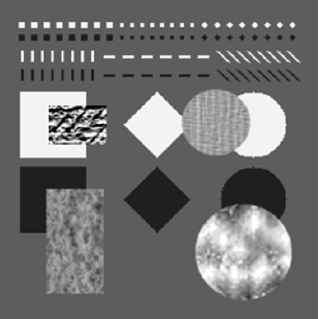
Figure 1: The noise-free test image (256 × 256) with four texture